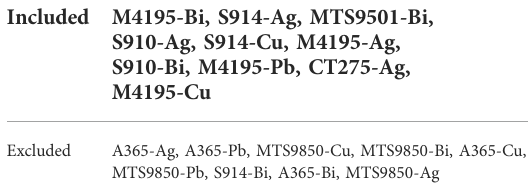
TABLE 4 The 10 candidate materials included in the group model, ranked in order of material offset. Table also includes the calculatedmeaniodidecapacityacrossallsamplesolutionsGreycells indicate materials for which precipitation was observed across multiple